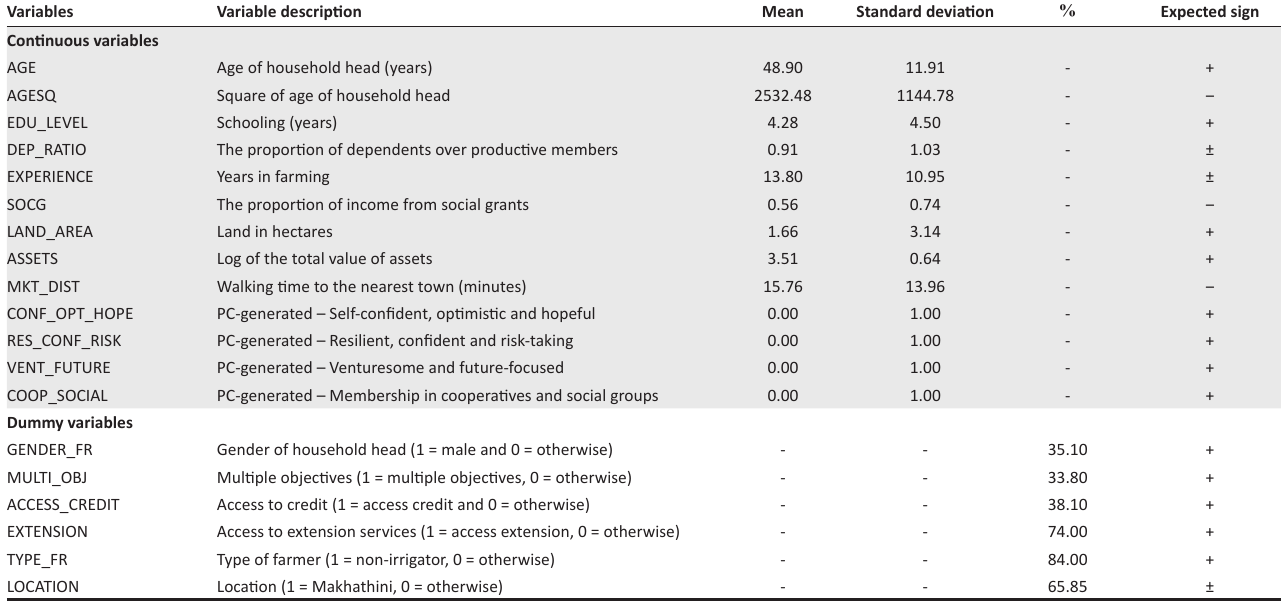
TABLE 1: Description of independent variables included in the model.